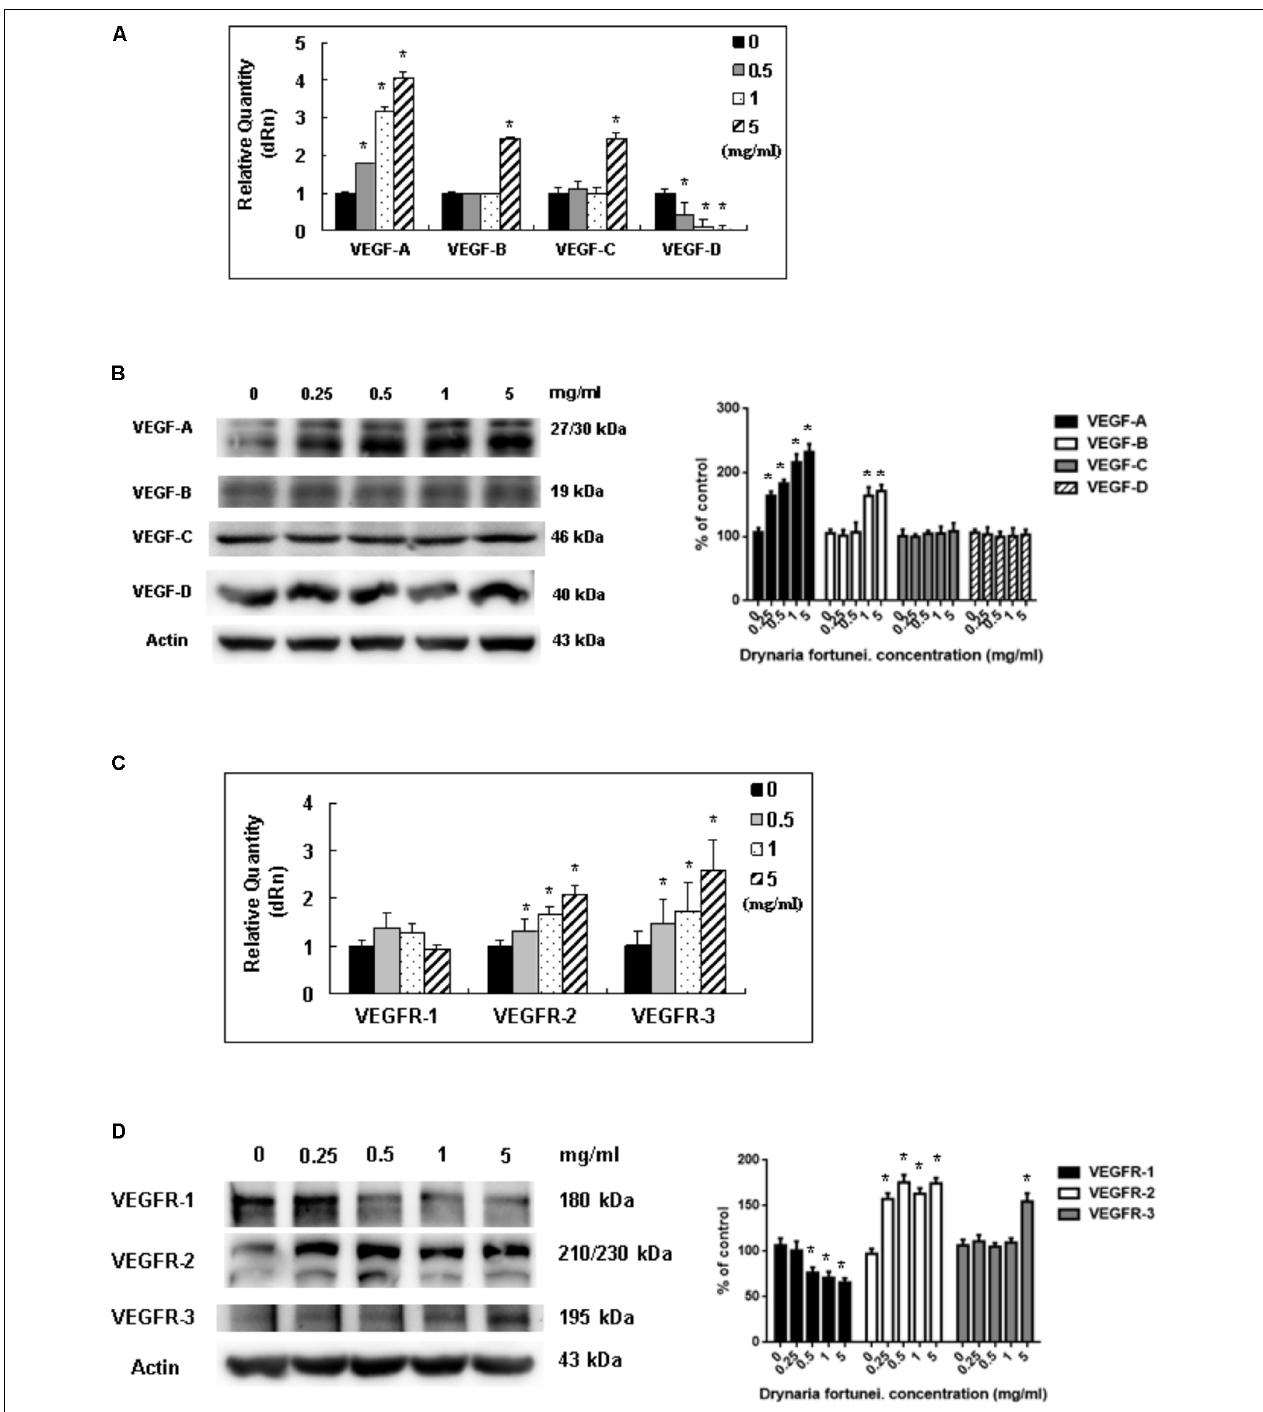
FIGURE 7 | The measurement of mRNAs and proteins of VEGFs and VEGFRs by D. fortunei. The relative quantity of mRNA and protein expression of VEGFs and VEGFRs with different concentrations of D. fortunei as indicated. (A) The mRNAs of VEGF-A, -B, and -C were stimulated by D. fortunei ; however, the mRNA of VEGF-D was suppressed. (B) As for the protein of VEGFs, the protein expressions of VEGF-A and VEGF-B were activated significantly by D. fortunei dose-dependently. However, the protein expression of VEGF-C and VEGF-D showed no significant change. (C) The mRNAs of VEGFR-2, and -3 were stimulated by D. fortunei ; however, the mRNA of VEGFR-1 showed no change. (D) As for the protein of VEGFRs, the protein expressions of VEGFR-2 and VEGFR-3 were activated significantly by D. fortunei dose-dependently. However, the protein expression of VEGFR-1 was slightly decreased. Data were mean ± SD calculated from three individual experiments. An asterisk demonstrated the significant difference ( ∗ P < 0.05) compared with control.